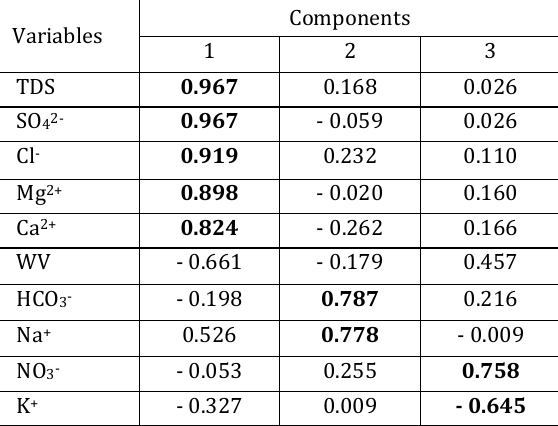
Table 2. Factor loading and eigenvalues of extracted components for the period from 2009 to 2013